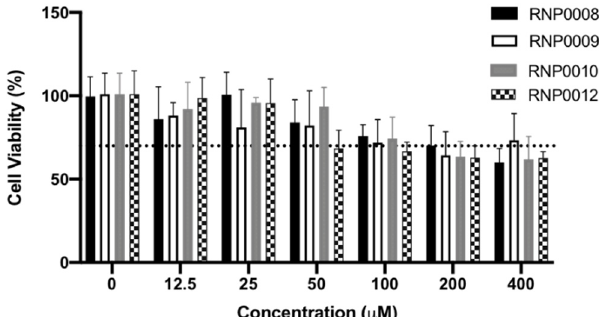
Figure 4. Effects of prioritized compounds on human cell viability. RNP0008 (black), RNP0009 (white), RNP0010 (grey), and RNP0012 (checkered) were added to HEPG2 cells in increasing concentrations ( x -axis). The dashed line represents the lower limit of tolerable cell viability, below which compounds are considered to have toxic effects. Values are an average of two experiments performed in triplicate.